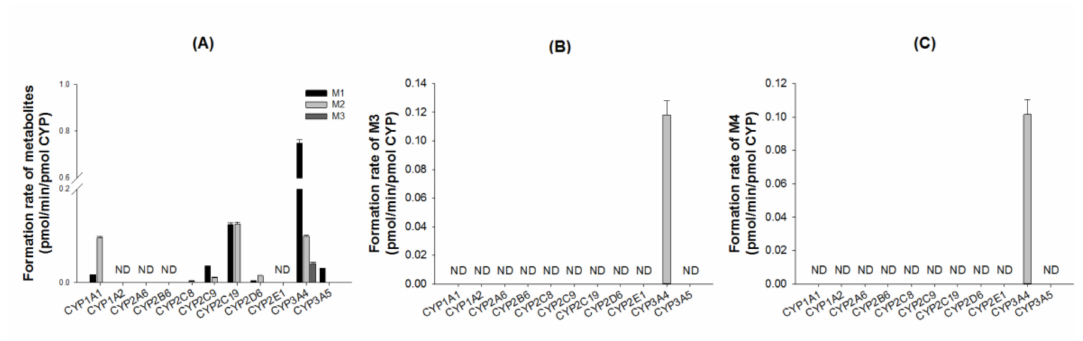
Figure 4. Formation rates of ( A ) M1, M2, and M3 from DWP16001 after incubation of 5 µ M DWP16001, ( B ) M3 from M1 after incubation of 10 µ M M1, and ( C ) M4 from M2 after incubation of 10 µ M M2 with human recombinant CYP enzymes (1A1, 1A2, 2A6, 2B6, 2C8, 2C9, 2C19, 2D6, 2E1, 3A4, and 3A5) in the presence of NADPH. ND: not detected (lower limit of quantification: 0.003 pmol / min / pmol